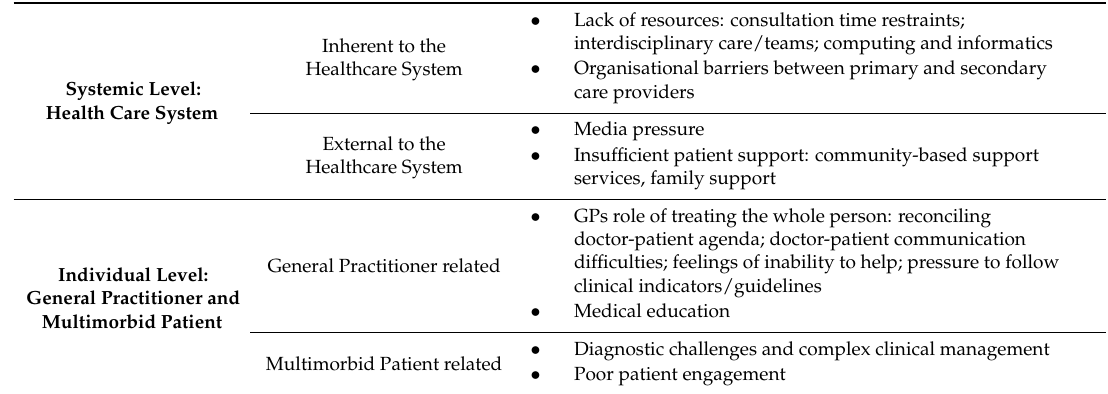
Table 2. Difficulties and